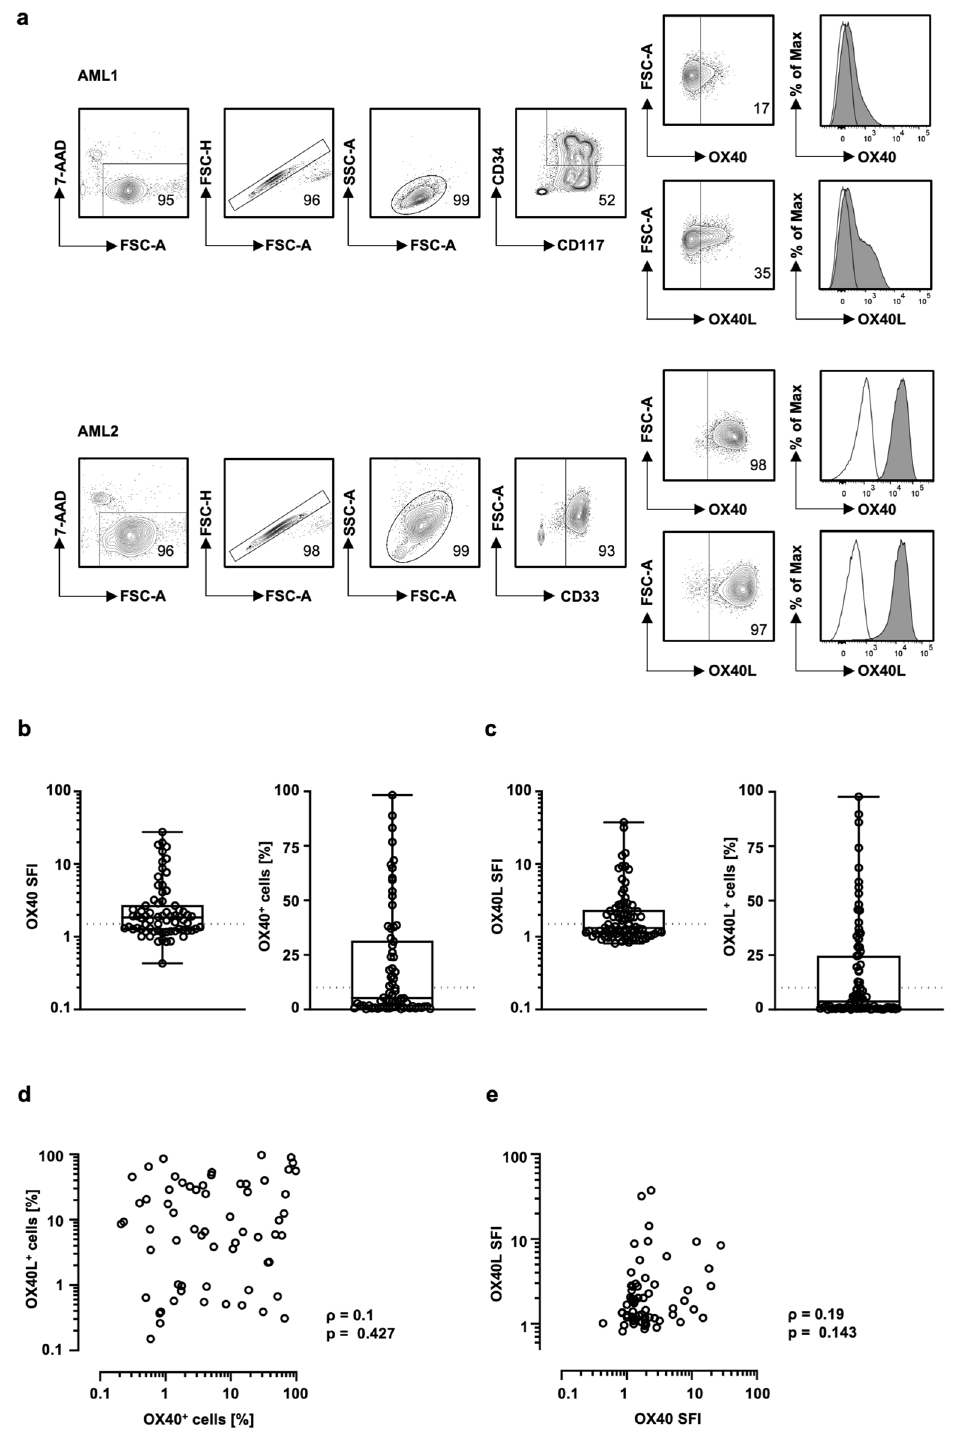
Figure 1. OX40 and OX40L expression on hematopoietic cells. OX40 expression was analyzed on hematopoietic cells by flow cytometry. ( a ) Gating strategy for two exemplary AML samples is outlined: viable (7-AAD − ), singlets, mononuclear cells, blast marker (AML1: CD34 + /CD117 + . AML2: CD33 + ) and OX40 or OX40L expression as percentage. The histogram shows the representative OX40/OX40L staining (filled peaks) and the corresponding isotype control (open peaks). ( b ) OX40 expression on blasts of AML patients are depicted as SFI levels (analyzed patients n = 70, positive patients n = 41) and percentage of OX40 positive blasts (analyzed patients n = 70, positive patients n = 30) (boxplots with min/max whiskers). SFI levels and percentage of positive cells above 1.5 and 10%, respectively, were considered as positive expression (dotted line). ( c ) OX40L expression on blasts of AML patients are depicted as SFI levels (analyzed patients n = 86, positive patients n = 37) and percentage of OX40 positive blasts (analyzed patients n = 86, positive patients n = 30) (boxplots with min/ max whiskers). ( d, e ) Correlation between the expression of OX40 + and OX40L + cells as percentage ( d ) and SFI ( e ) ( p value and spearmans